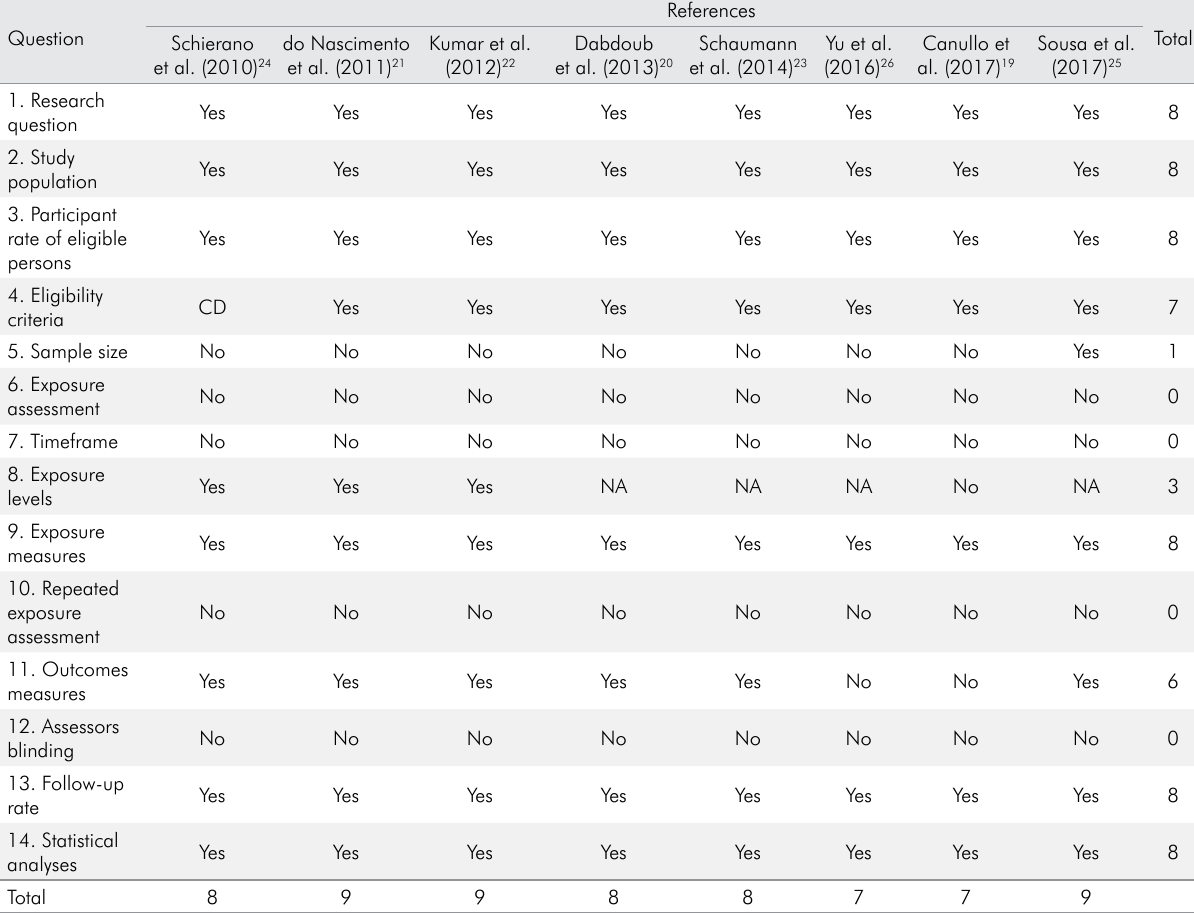
Table 7. Quality assessment of the included studies according to the NIH Quality Assessment Tool for Observational Cohort and Cross-Sectional